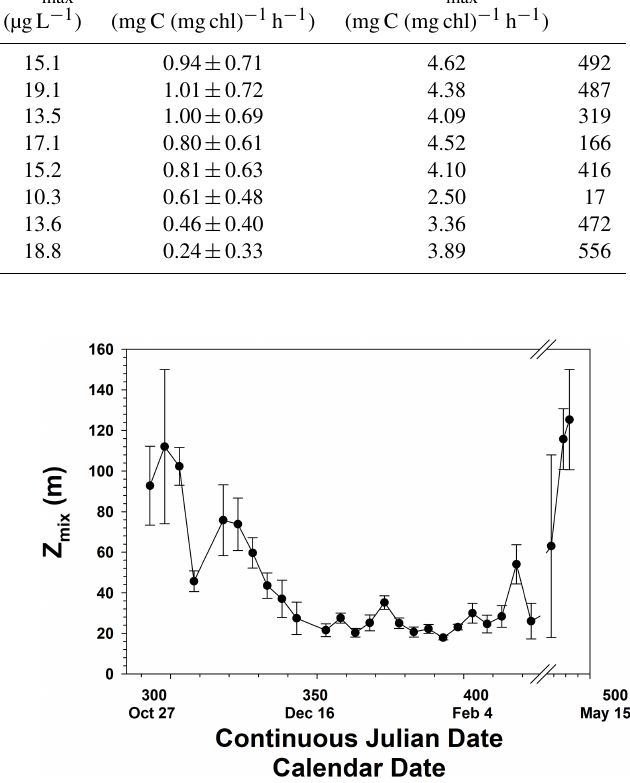
Figure 3. Seasonal progression of mixed layer depth ( Z mix ). All mixed layers greater than 150m were set equal to 150m. Error bars represent the standard deviation from the mean. Gaps in time were periods when no data were collected.